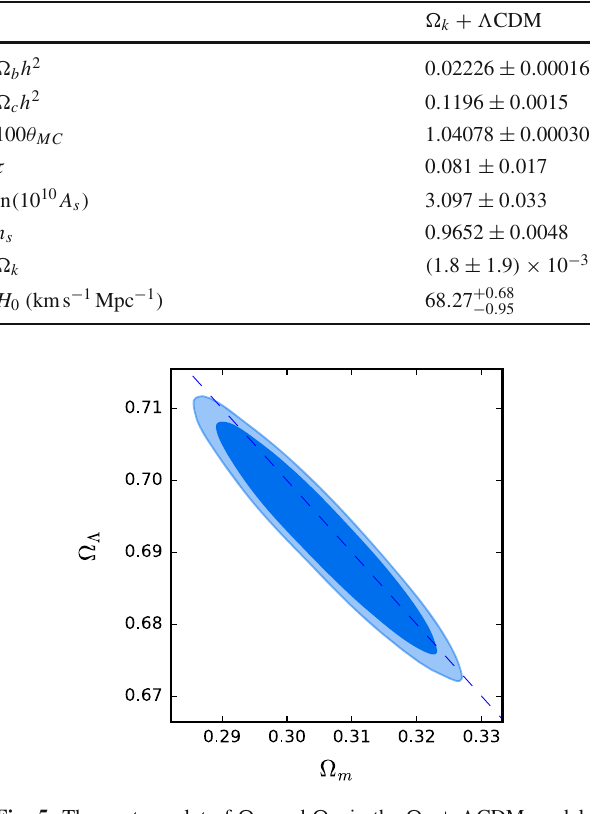
Fig. 5 The contour plot of (cid:3) m and (cid:3) (cid:2) in the (cid:3) k + (cid:2) CDM model. The dashed line indicates (cid:3) m + (cid:3) (cid:2) =